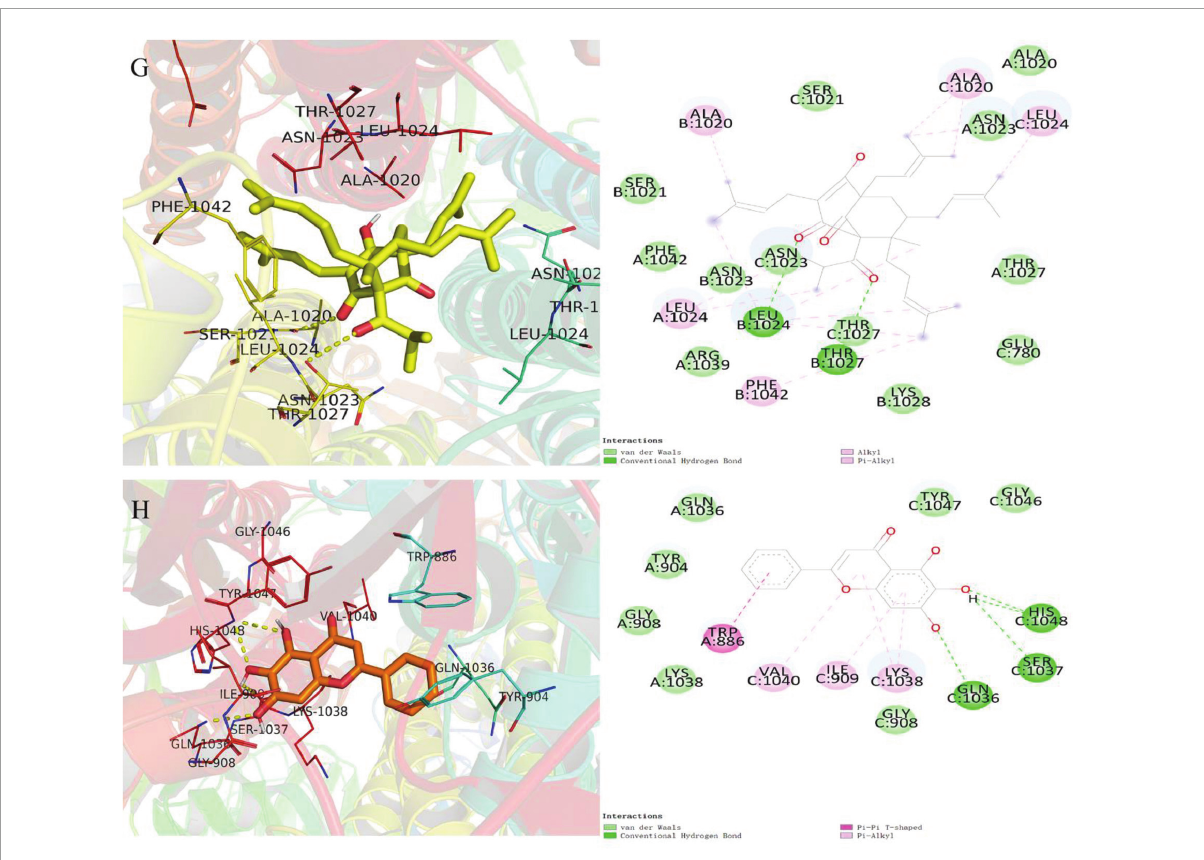
FIGURE10 Molecular models of the selected compounds binding to the target proteins. (A) The docking mode and interactions between shinflavanone and 3CL. (B–C) Shinflavanone, beta-carotene and ACE2. (D–H) Shinflavanone, beta-carotene, beta_sitosterol, hyperforin, baicalein and S protein.